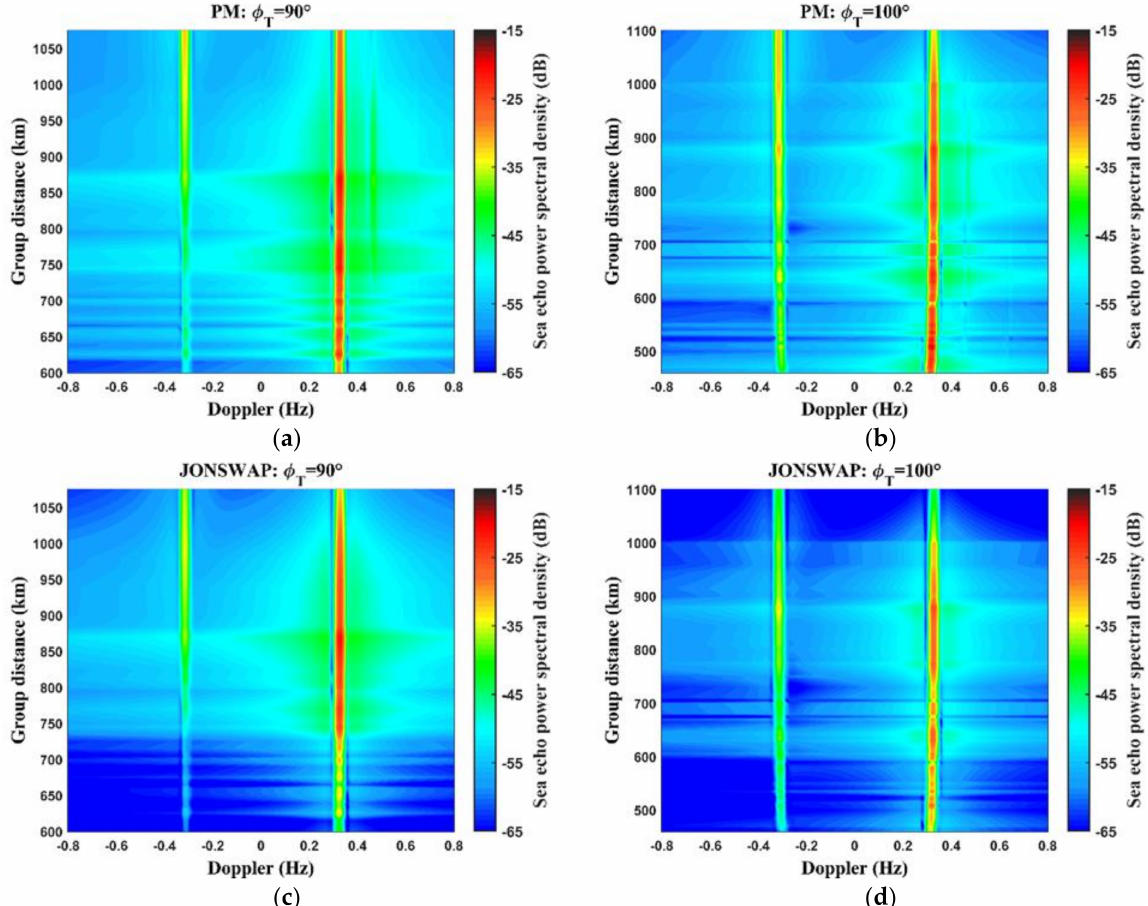
Figure 7. SWR RD spectra simulated by the sea echo signals returning along the incidence path based on the PM spectrum and JONSWAP spectrum. ( a ) PM spectrum, ϕ T = 90 ◦ . ( b ) PM spectrum, ϕ T = 100 ◦ . ( c ) JONSWAP spectrum, ϕ T = 90 ◦ . ( d ) JONSWAP spectrum, ϕ T = 100 ◦